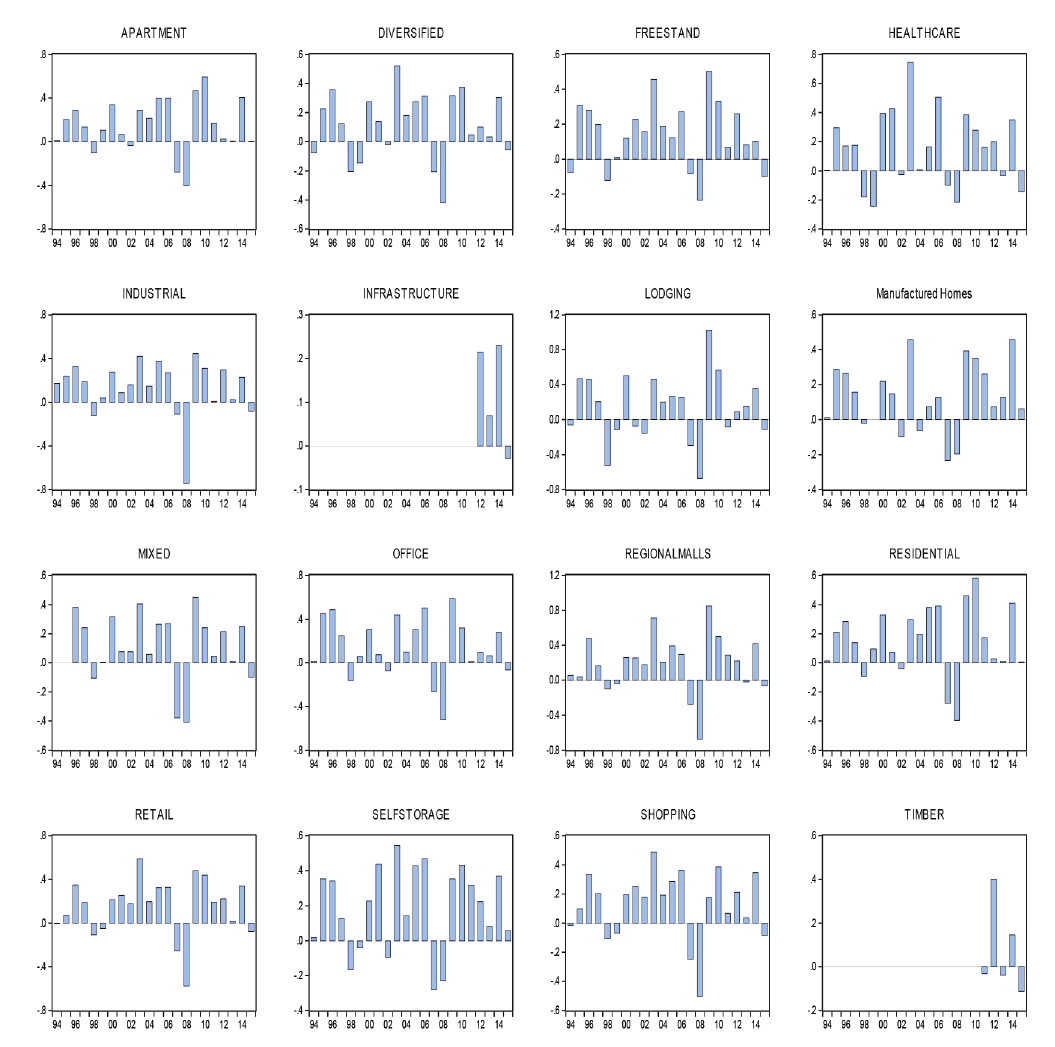
Figure 1. Annual returns of REIT